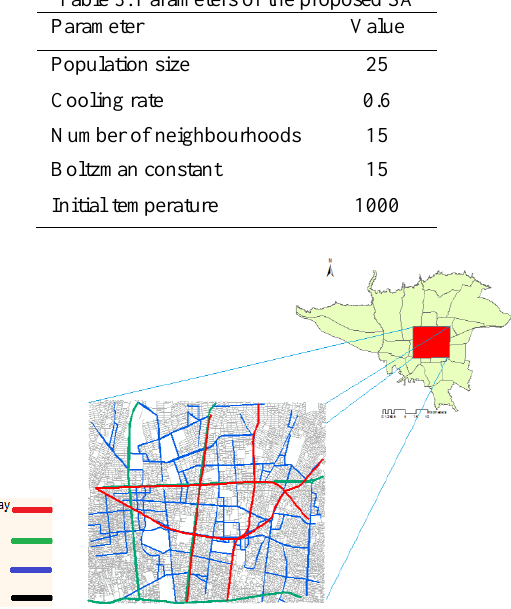
Figure 11. The study area